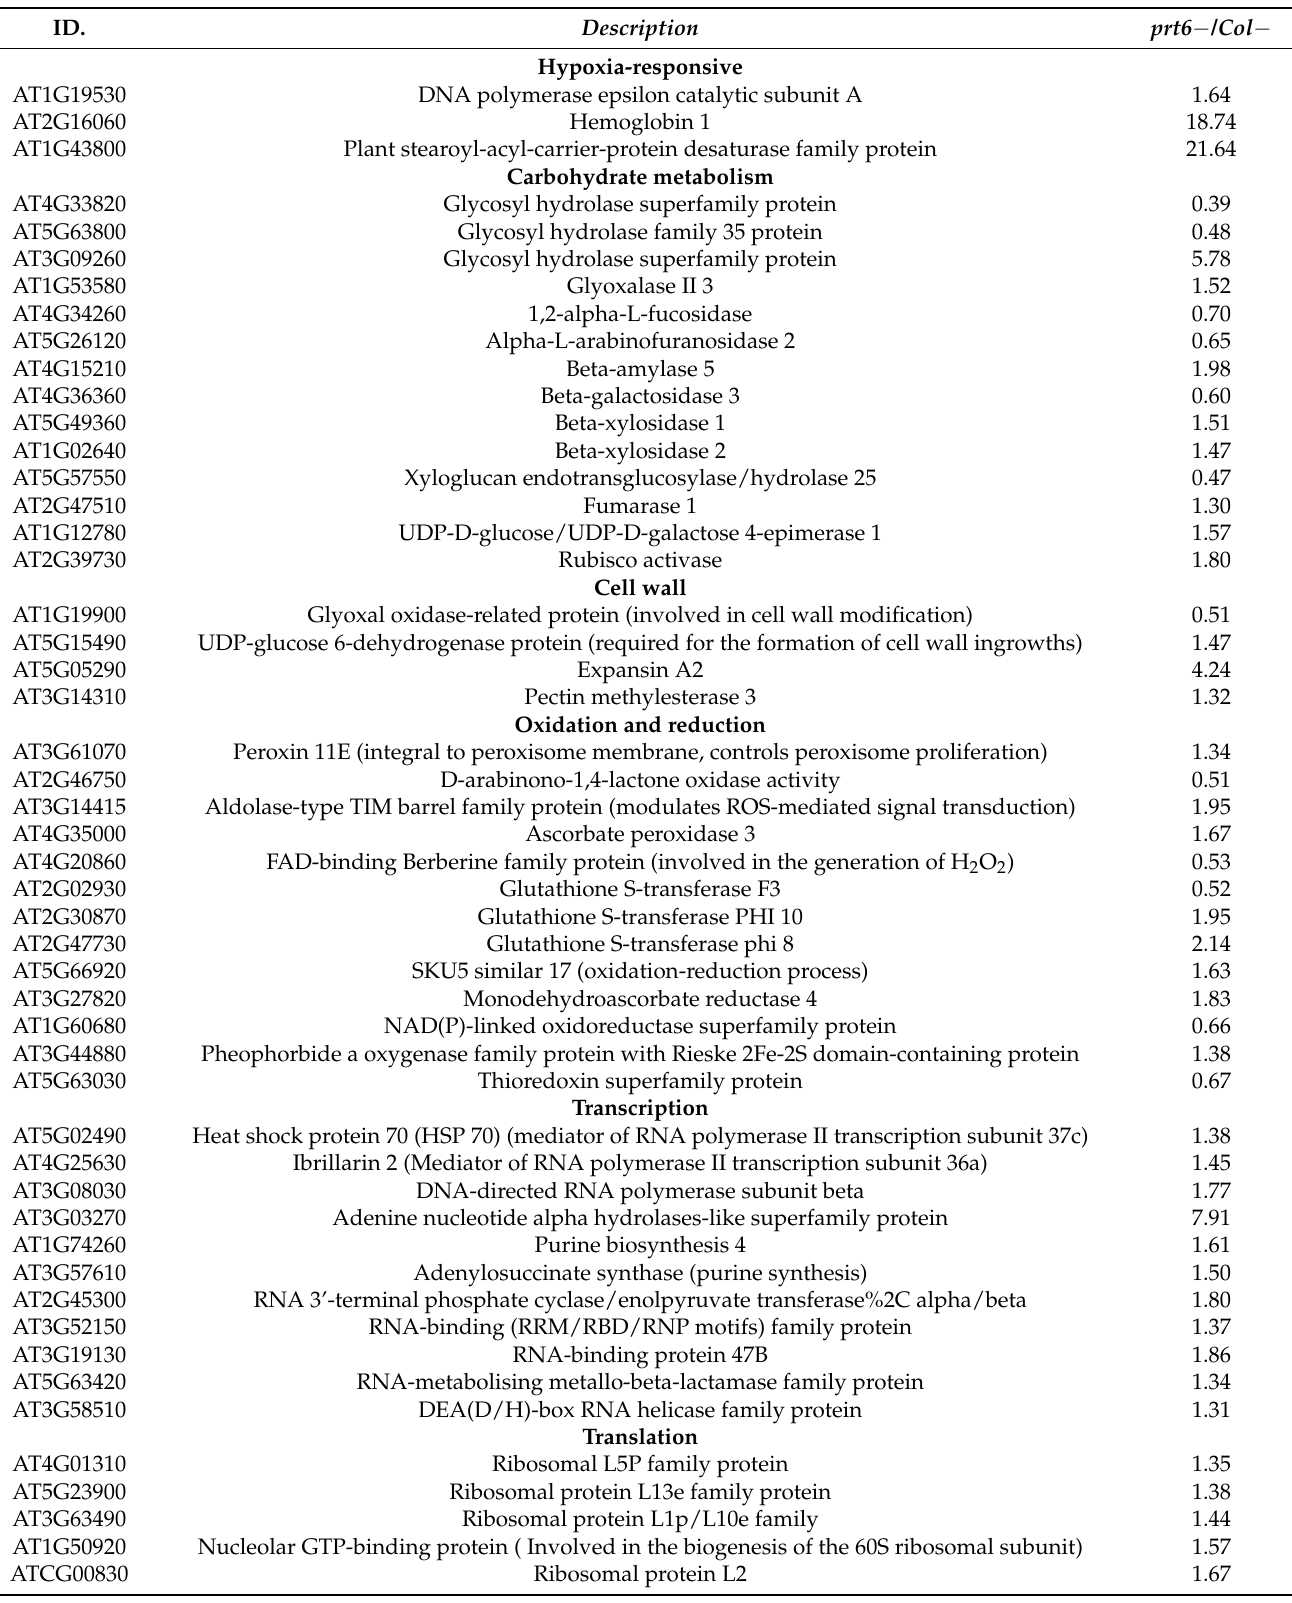
Table 2. Classified DEPs from comparison group prt6 − /Col − . Except for 19 proteins which were miscellaneous, 80 out of 100 significant proteins in group prt6 − /Col − are shown